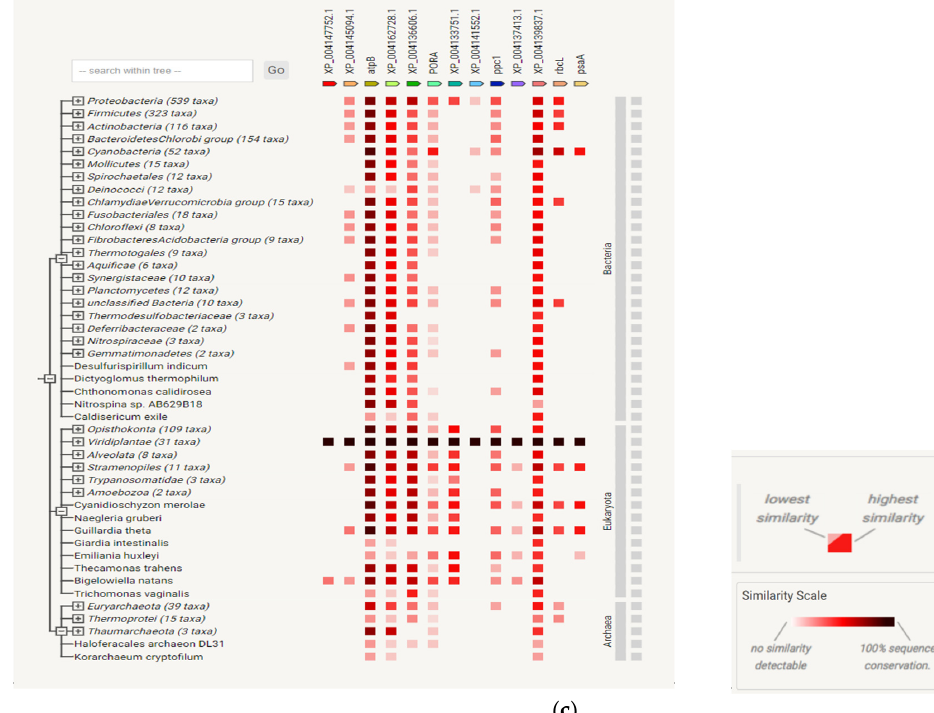
Figure 12. STRING analysis of ( a ) more abundant, ( b ) less abundant, and ( c ) gene co-occurrence Figure 12 . STRING analysis of (a) more abundant; (b) less abundant and (c) gene co-occurrence patterns across genomes shows patterns across genomes shows similarities